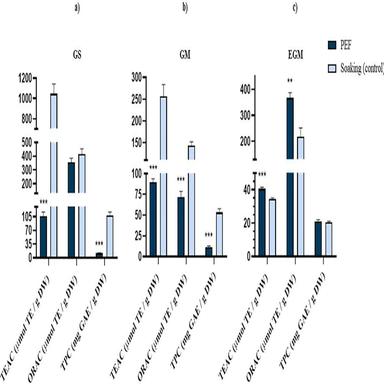
Total antioxidant capacity (TEAC, ORAC) and polyphenols content (TPC) of the liquid crudes obtained by pulsed electric field (PEF)-assisted extraction from the winemaking waste grape stalks (GS) (a), grape marc (GM) (b) and exhausted grape marc (EGM) (c). Results for TEAC and ORAC are expressed as µmol Trolox Equivalent/g dry weight (µmol TE/g DW), and for TPC as mg Gallic Acid Equivalents/g dry weight (mg GAE/g DW) (both as mean ± SD). p < 0.001; p < 0.01 vs. control.